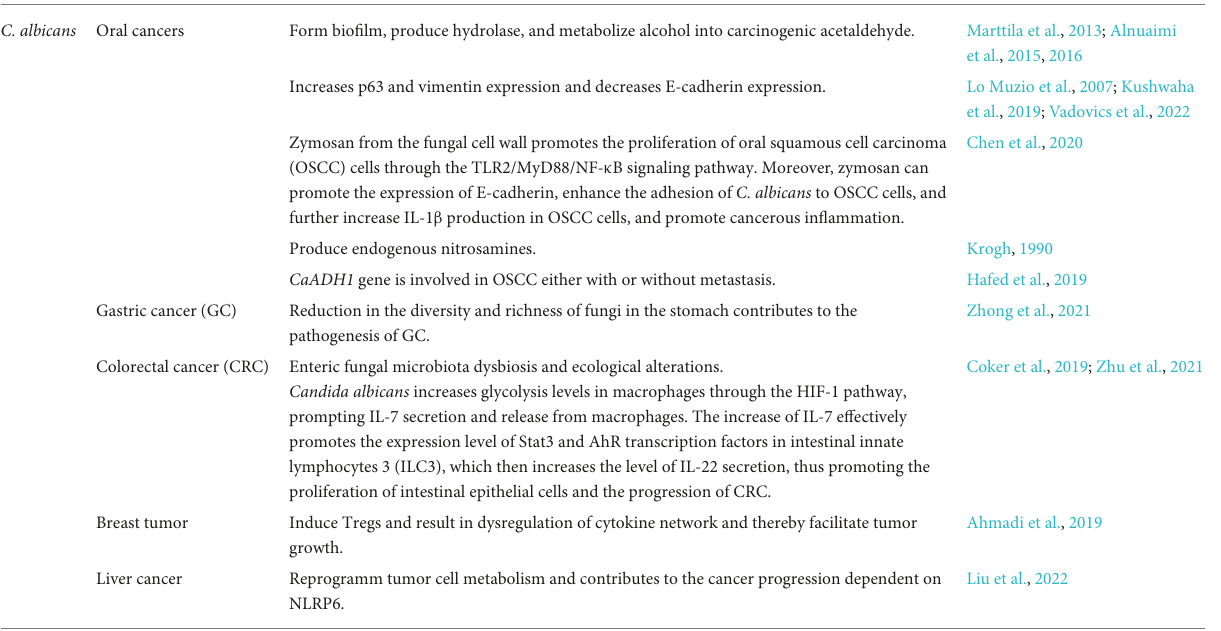
TABLE 1 The association of C. albicans and